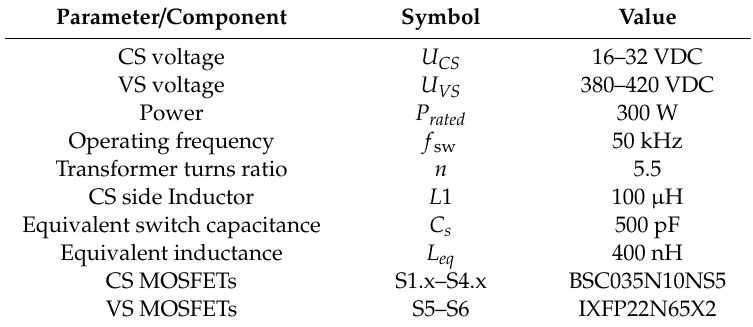
Table 2. Main converter parameters and components. CS: current source; VS: voltage